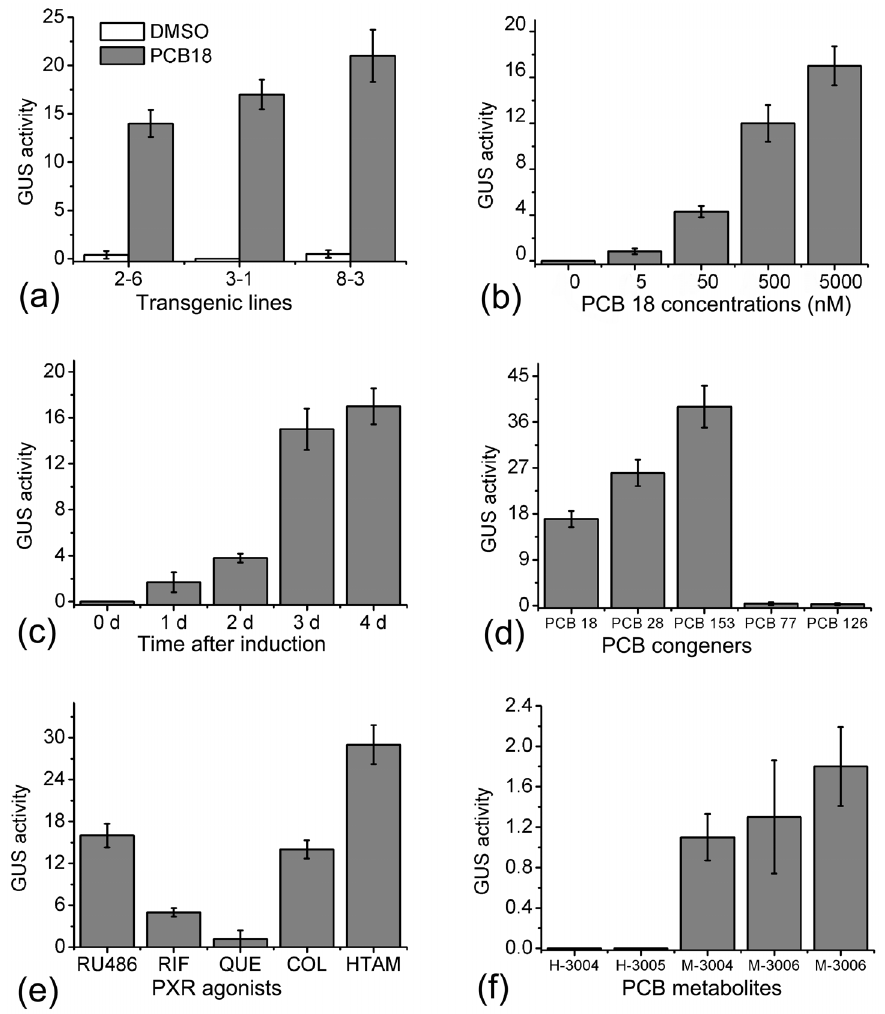
Figure 3. Dose- and time-dependent GUS activities in NDL-PCB Reporters in response to PXR ligands. (a) Induced GUS activity in three transgenic lines in response to 5 m M PCB 18. (b) Dose-dependent GUS activity upon treatment with various concentrations of PCB 18. (c) Time- dependent GUS activity in response to 5 m M PCB 18. (d) GUS activity was responsive to NDL-PCBs but insensitive to DL-PCBs. (e) Response of GUS activity to typical PXR agonists. (f) Methoxyl- PCBs could induce low GUS activity, while hydroxyl-PCBs could not. Six-d-old seedlings were transferred to plates with indicated chemicals and grown for 4 d before GUS activity analysis. Chemicals in (d) to (f) were at concentrations of 10 m M.